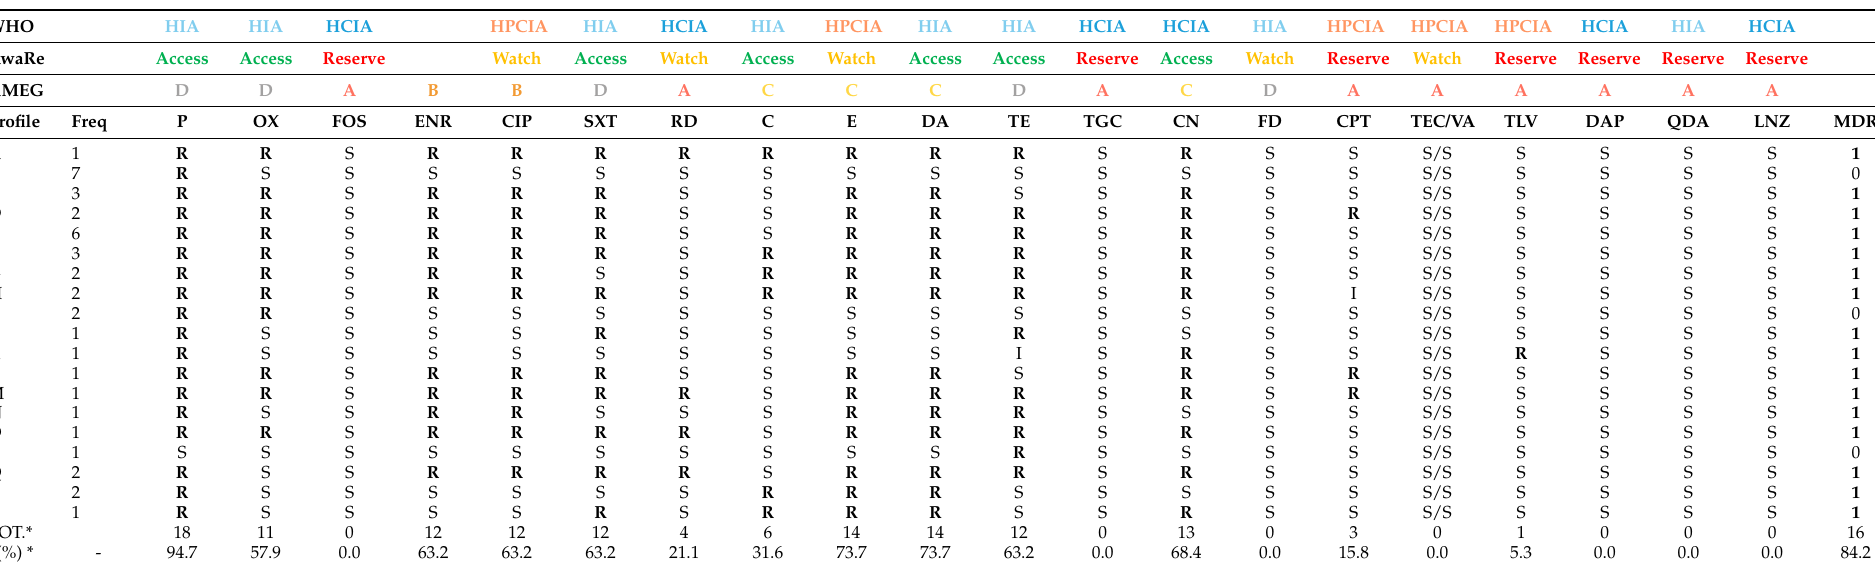
Table 3. Resistance profiles with World Health Organization (WHO, AWaRe) and European Medicine Agency (AMEG) classifications. For each antibacterial and MDR, the prevalence of resistant profiles is